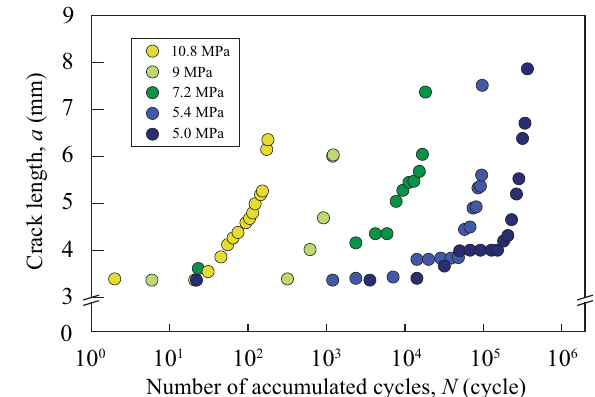
Fig. 5 Stress – Life fatigue behavior of copy paper. The high-cycle fatigue life ( N f ) was measured as a function of the applied alternating stress range ( Δ σ ). The fatigue lives ranged from <100 to ~10 6 cycles to failure for stress ranges that were bounded by the notched specimen ultimate and yield strengths, respectively (dashed lines). The error bars were smaller than the symbols used to denote the fatigue lives.